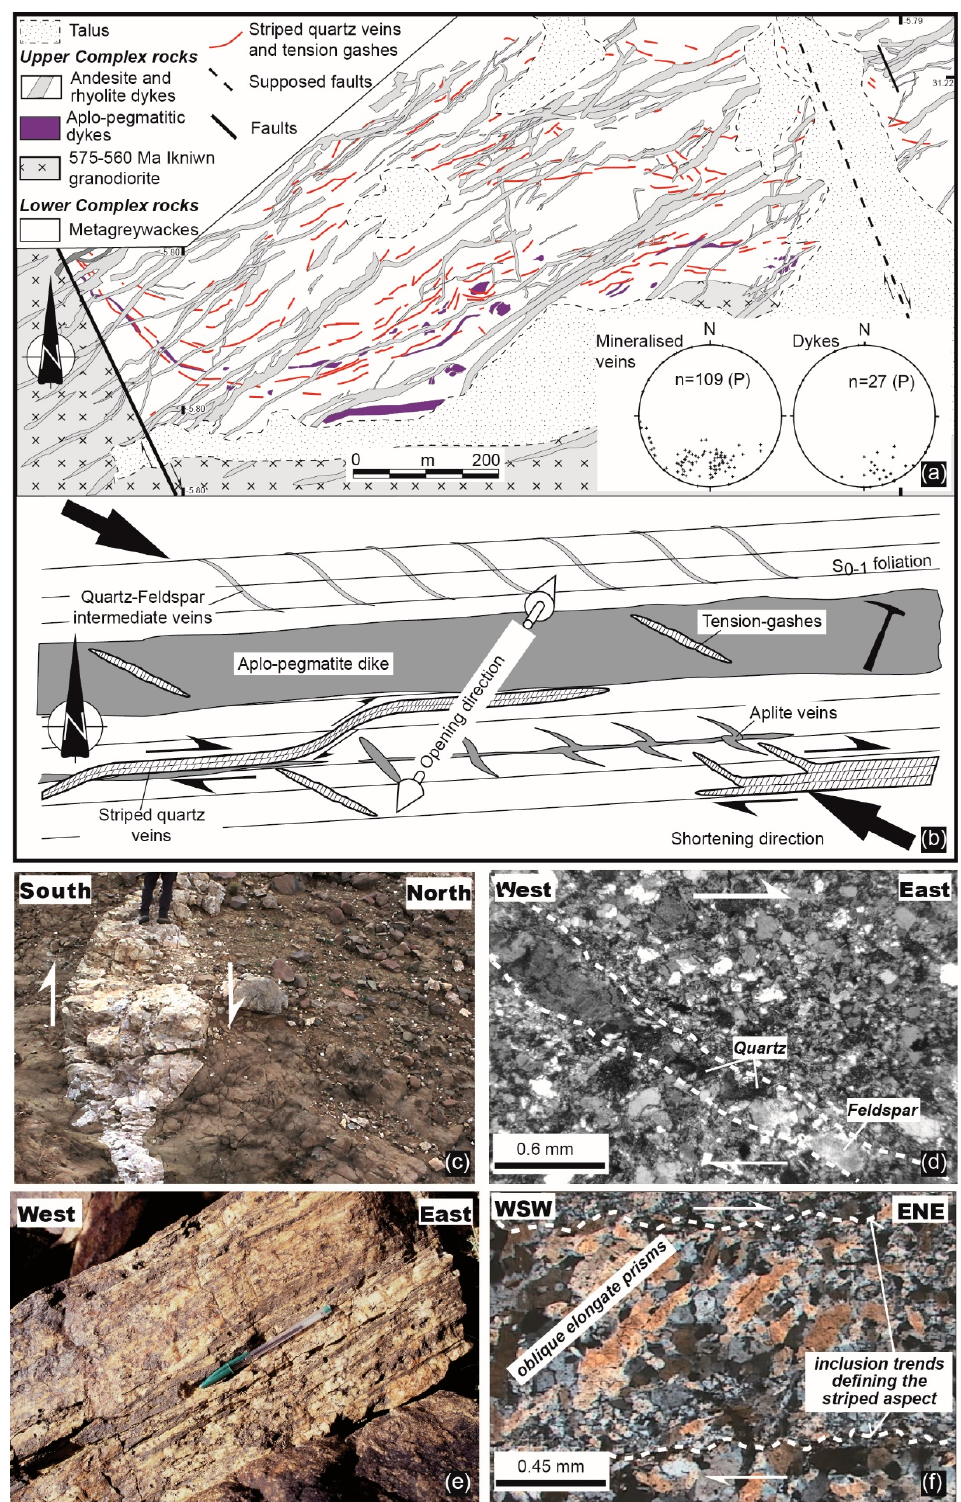
Figure 8. Main features of the Taghassa intrusion ‐ related gold deposit (IRG) [47,48]. ( a ) General map and stereoplots of structural orientation data of the Au ‐‐ Ag Thaghassa intrusion ‐ related gold deposit. These reveal the high density of veins developed north of the 575 – 560 Ma Ikniwn granodiorite. ( b ) Interpretative sketch illustrating the magmatic ‐ hydrothermal model that involved a progressive and continuous tectonic event including the aplo ‐ pegmatitic dykes and sills emplacement, then the intermediate veins and the hydrothermal and gold ‐ rich striped quartz veins. ( c ) Pegmatite dyke